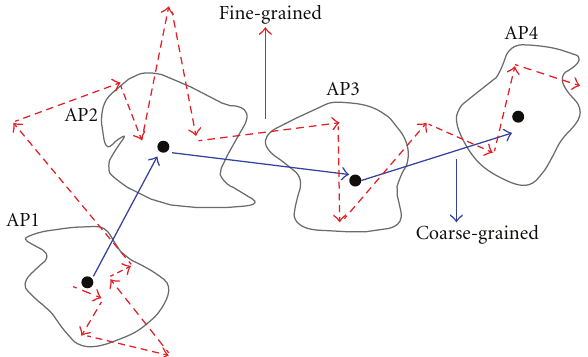
Figure 1: Fine and coarse-grained location information collected for an example